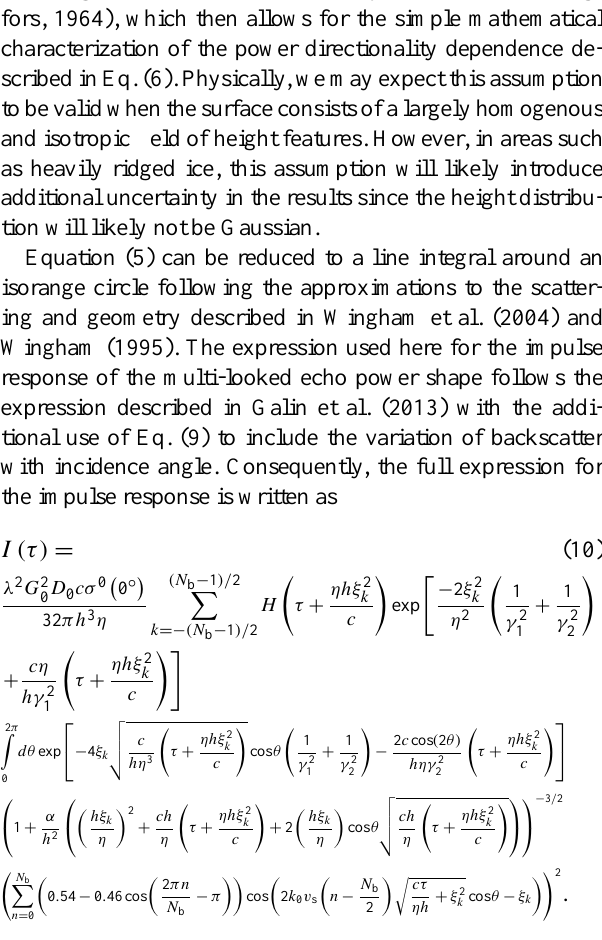
Table 1 summarizes the parameters and symbols used in the above equation. The expression after the summation in the second, third, and fourth lines of Eq. (10) corresponds to the contribution of the elliptical antenna pattern, which is taken from Wingham and Wallis (2010). The fifth line of Eq. ( 10) corresponds to the variation of backscatter with incidence an- gle. The sixth line corresponds to the gain of each synthetic beam and the application of a Hamming window. The form of the equation accounts for the slant range correction of each synthetic beam which is employed in the CryoSat level 1B data